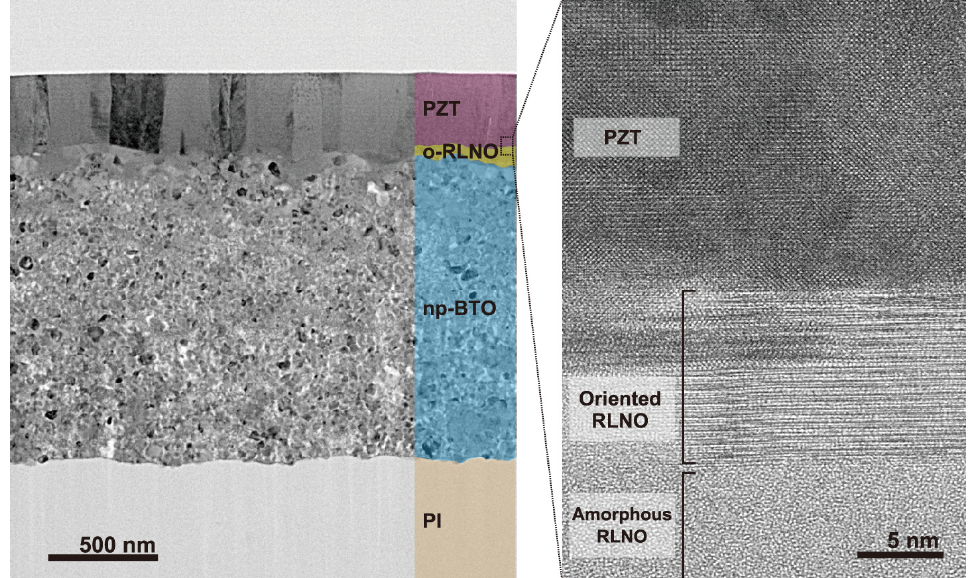
Figure 8. XTEM image of the PZT/RLNO/BTO/PI and high-resolution lattice image at the interface between PZT and the (010)-oriented RLNO film surface. o- and np- represent “oriented” and “nanoparticle-derived”, respectively.